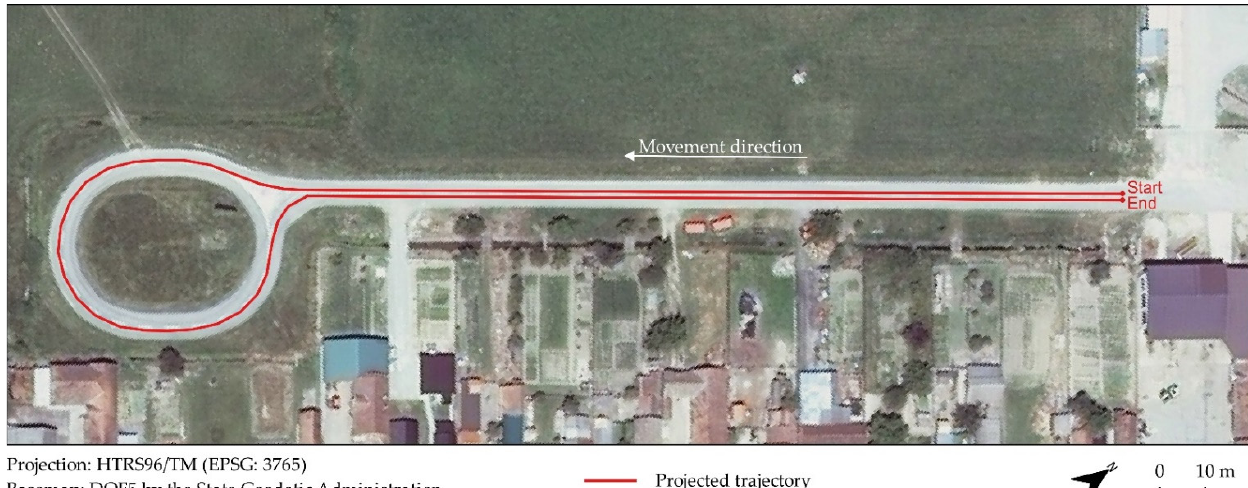
Figure 1. Study area and the trajectory for the accuracy assessment of GNSS RTK corrections.